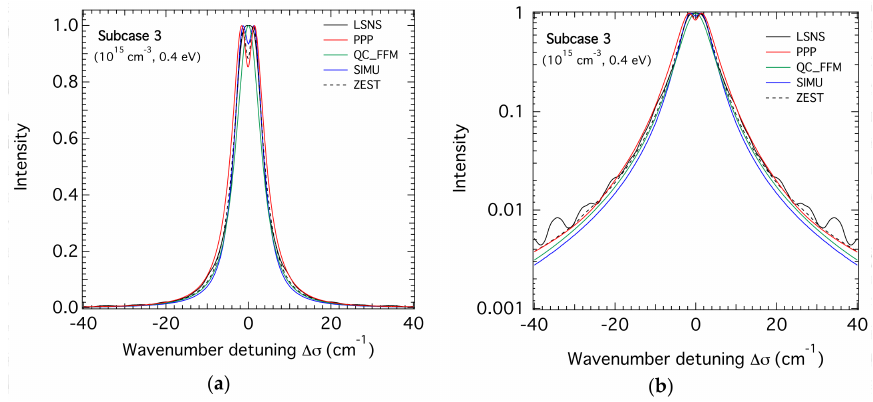
Figure 3. The same as Figures 1 and 2 with the same line styles and code colors but T e = T i = 0.4 eV. ( a ) linear scale; ( b ) semi-logarithmic